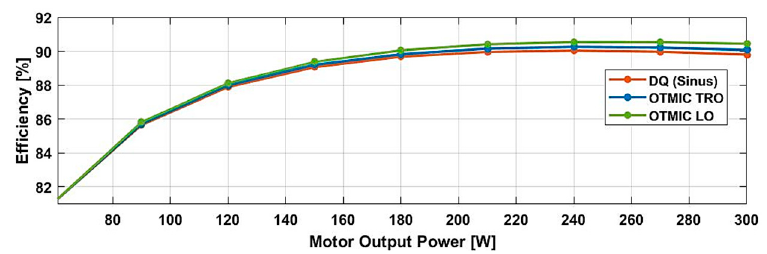
Figure 10. Motor efficiency for OTMIC and DQ control. Figure 10. Motor e ffi ciency for OTMIC and DQ